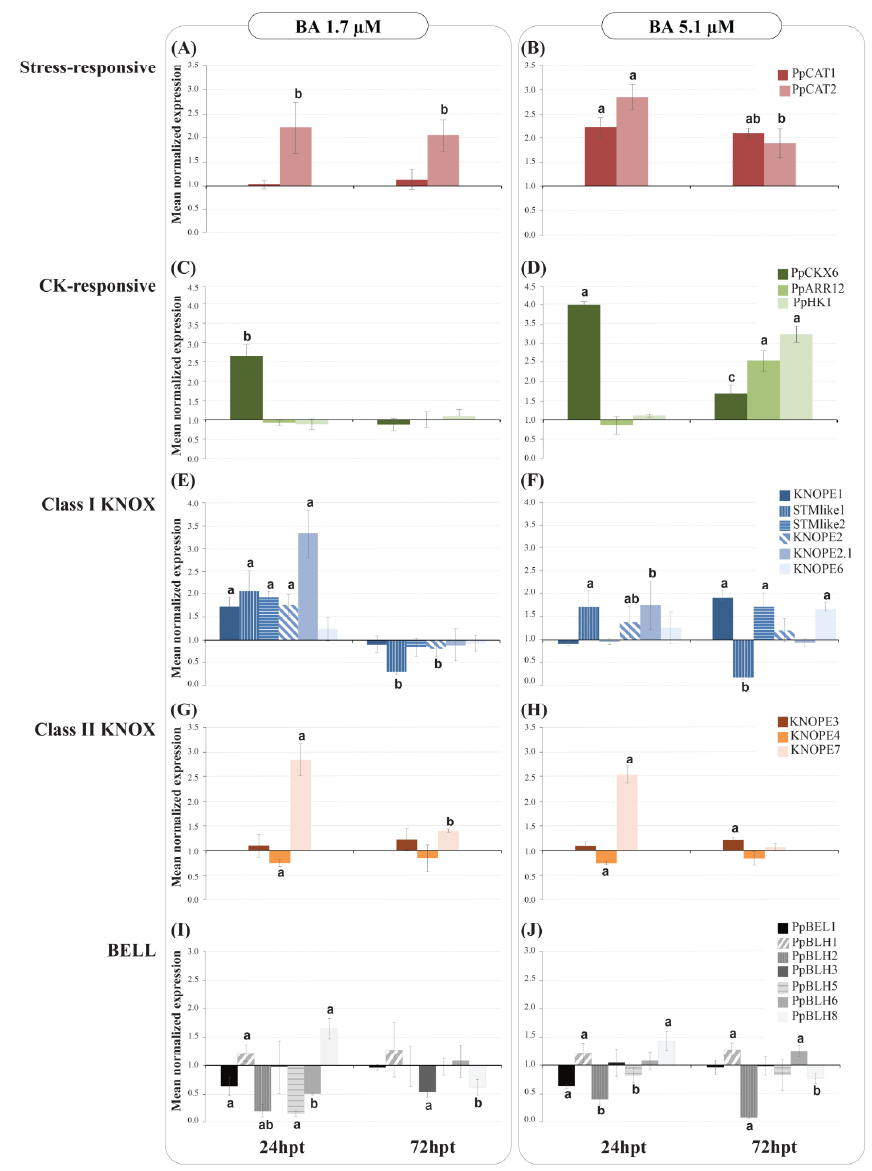
Figure 7. Gene expression analyses of KNOPE and marker genes under different BA dosages. Expression levels of stress- ( A , B ) and CK-responsive ( C , D ) markers and of KNOPE ( E , H ) and BELL ( I , J ) genes in response to 1.7 µM ( A , C , E , G , I ) and 5.1 µM ( B , D , F , H , J ) of BA at 24 and 72 h post- treatment (hpt). Each value represents the mean ± standard error of three replicates. For each gene, different letters mean significant differences ( p ≤ 0.05).